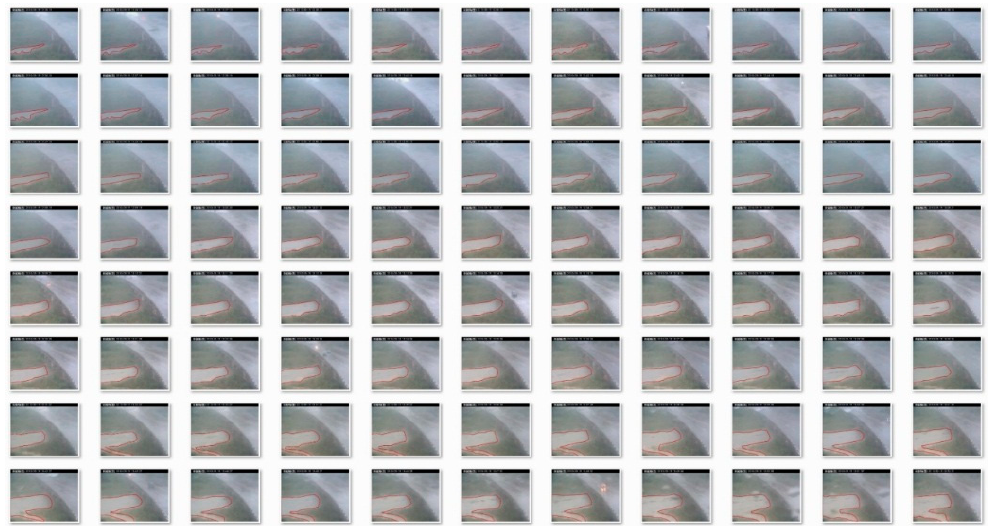
Figure 7. Part of the ground truth of the image set. The red boundaries are manually-labeled segments of flood regions. (Note: The Traditional Chinese in header of all images is represented the location in the Changed Bridge except).